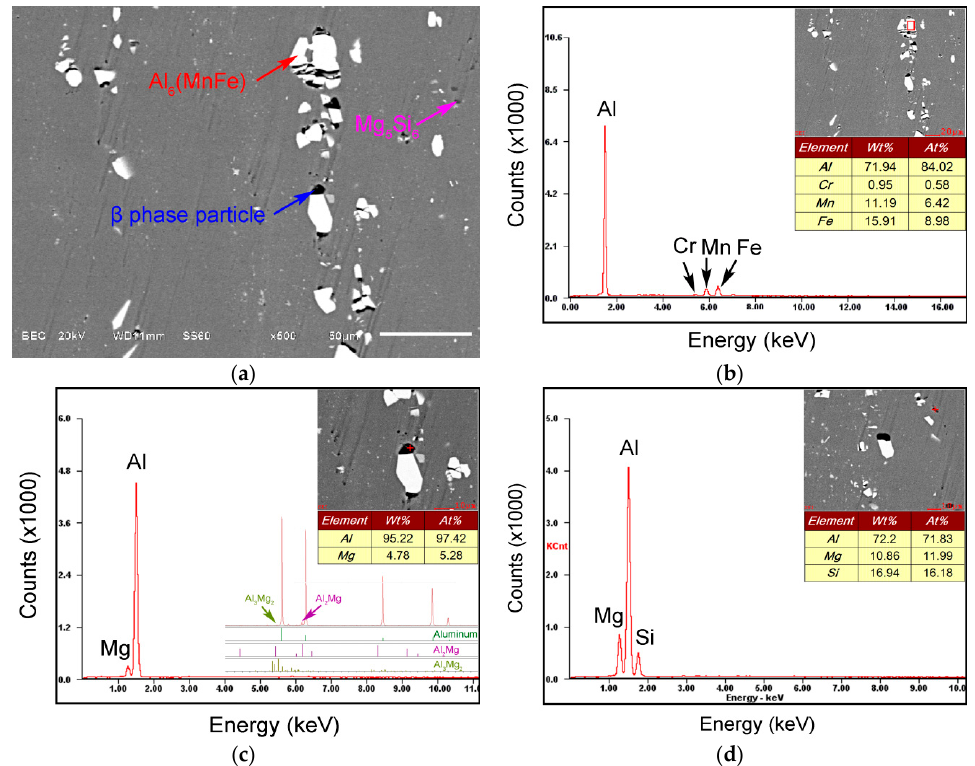
Figure 11. Formation and composition of the dispersed phase particle morphology at full recrystallization ( a ), and the EDS/X-ray diffraction results of Al 6 (Mn,Fe) phase ( b ), β phase ( c ), and Mg 5 Si 6 phase ( d